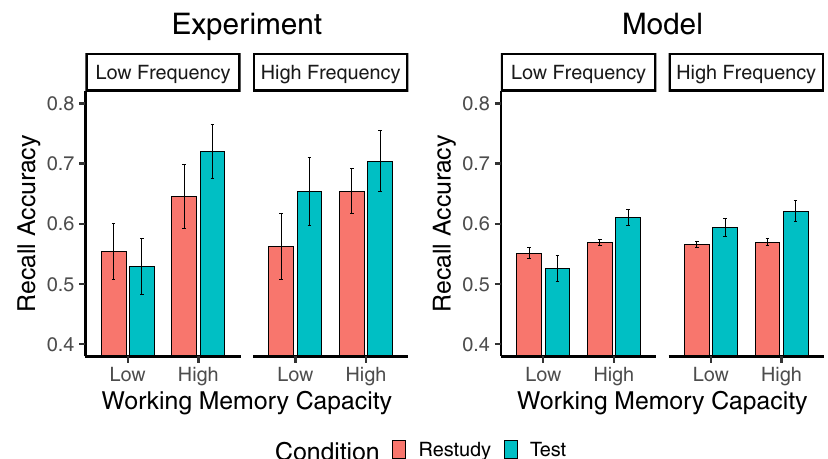
Fig. 4 The simulation results captured the critical three-way interaction in the experiment. While all participants bene fi ted from testing in HF associations, only participants with higher WM capacity showed the testing effect in LF associations. Error bars represent standard errors of the